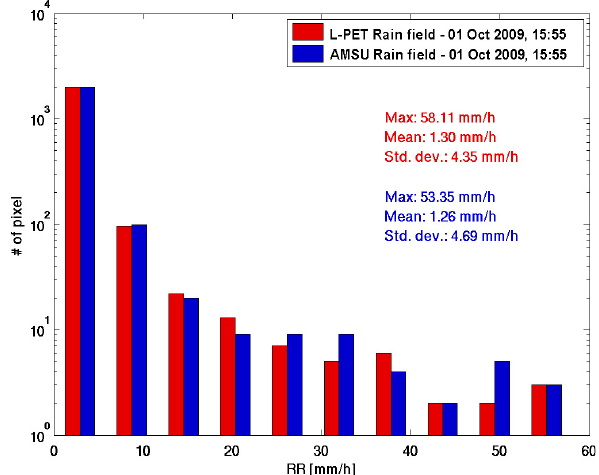
Fig. 8. Statistics of rain field provided by the AMSU-based al- gorithm applied to TB from NOAA 15 satellite (blue) and rain field provided by L-PET algorithm (red), over southern Italy region, 1 October 2009 at